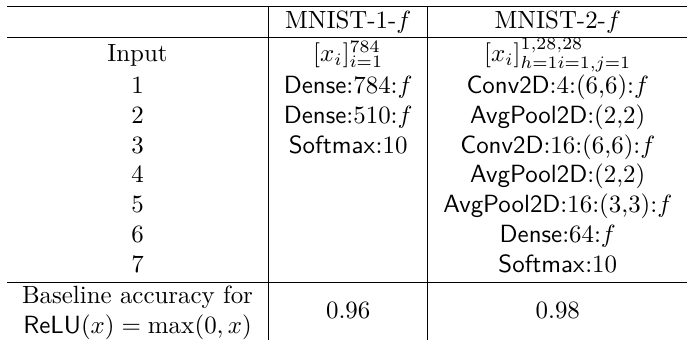
Table 9: Neural Networks Specification. The table contains specifications for both models that we train and evaluate and the baseline accuracy of the non-discretised model using floating point numbers. The “input” row gives the dimension of the inputs. The last row reports on the accuracy of the neural network. Other rows specify the given layer of the neural